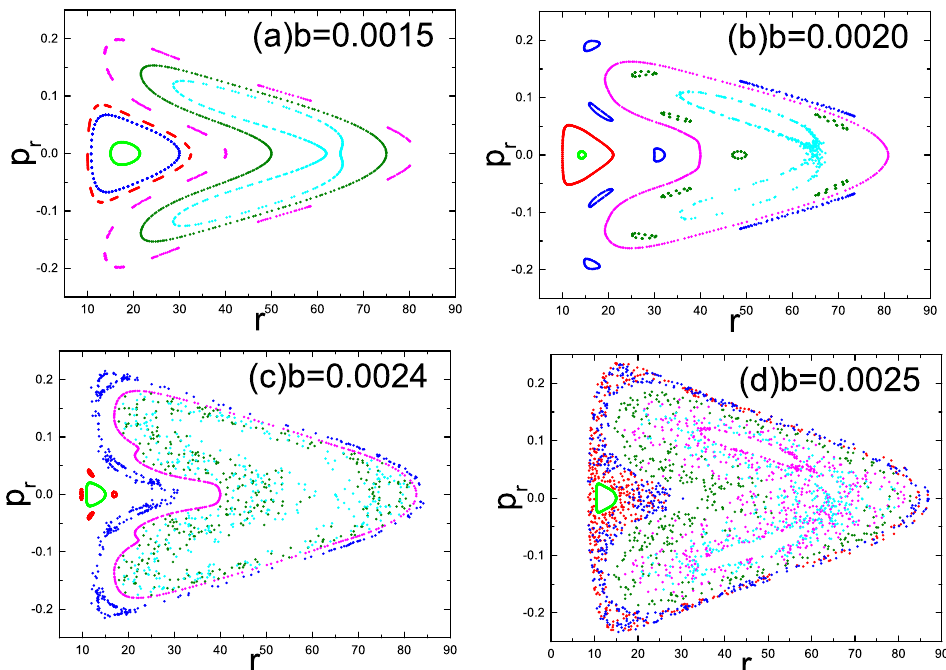
Figure 2. Dependence of the orbital dynamics on electromagnetic parameter b . Poincaré sections with the same parameters E = 0.9900, L = 4.6, α = 10 − 12 , β = 0, and different positive values of electromagnetic parameter b are given. The orbits are same as in Figure